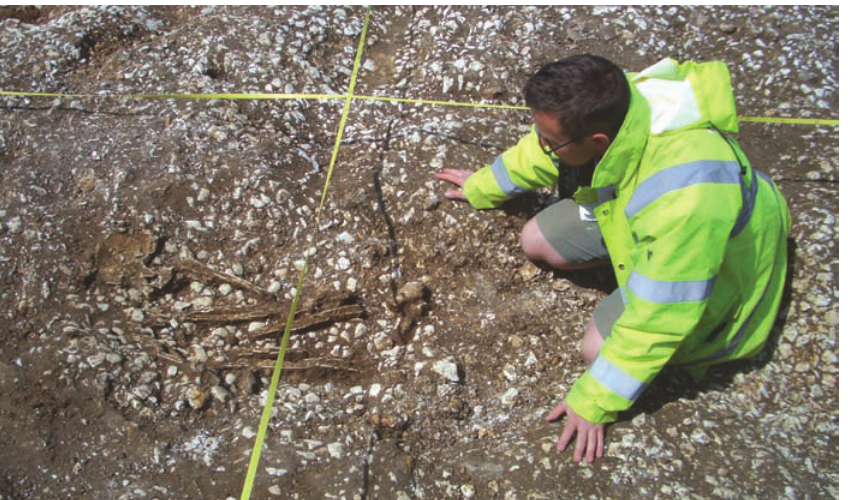
Figure 4 Excavation of the skeleton in Trench 8